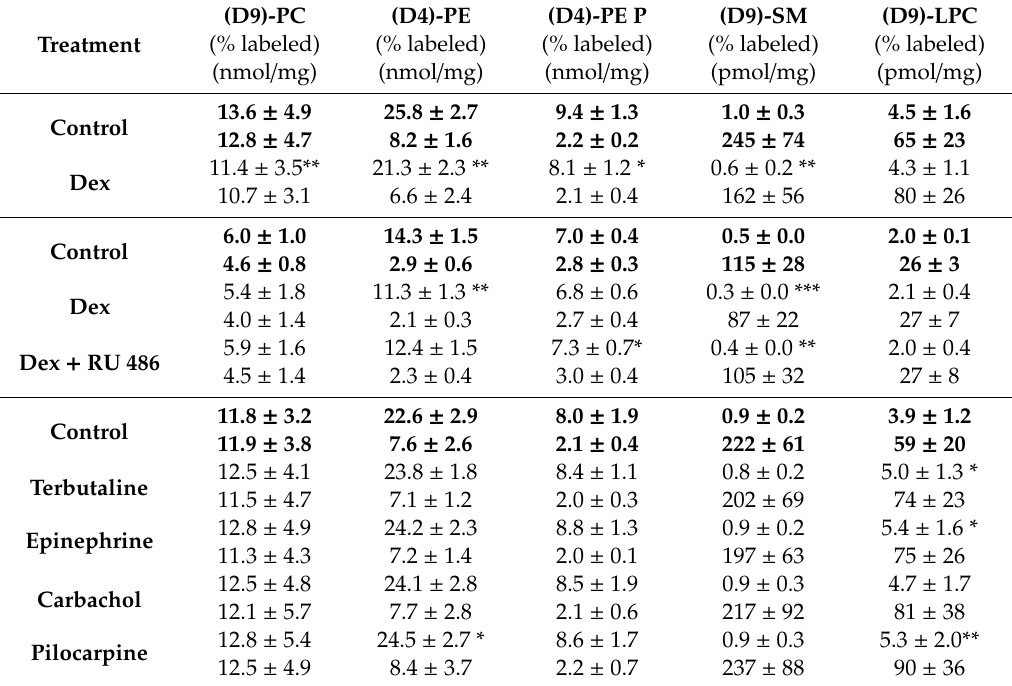
Table 1. The e ff ect of dexamethasone as well as adrenergic and muscarinic receptor agonists on the biosynthesis of